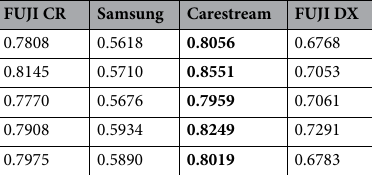
Table 8. M MAnnot AUC for each CXR equipment on CHVNGE for each cross validation fold. Bold indicates the highest AUC for each fold.